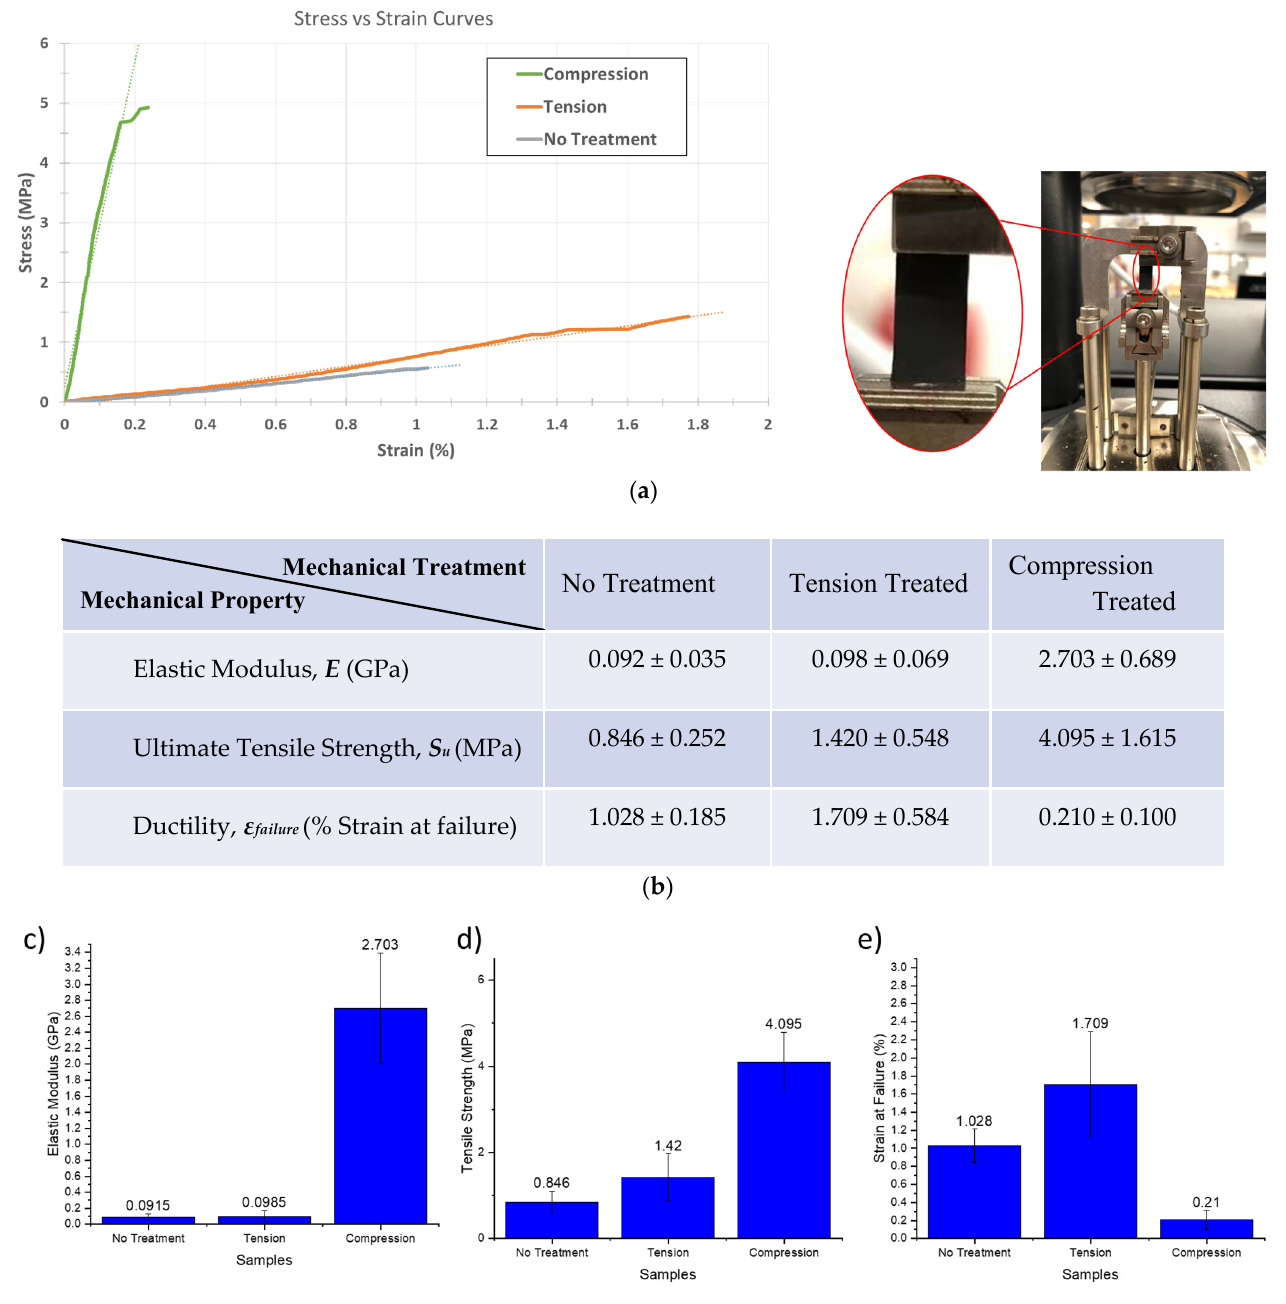
Figure 5. ( a ) Right: Representative stress–strain diagrams of all three carbon samples; Left: Photo of Dynamic Mechanical Analyzer with the pyrolytic carbon nanofiber mat attached to tensile test fixtures, ( b ) table of mechanical properties of the different types of carbons, and ( c – e ) bar graphs illustrating the differences in elastic modulus, ultimate tensile strength, and ductility in CIPC, TIPC, and no-treatment carbon samples.